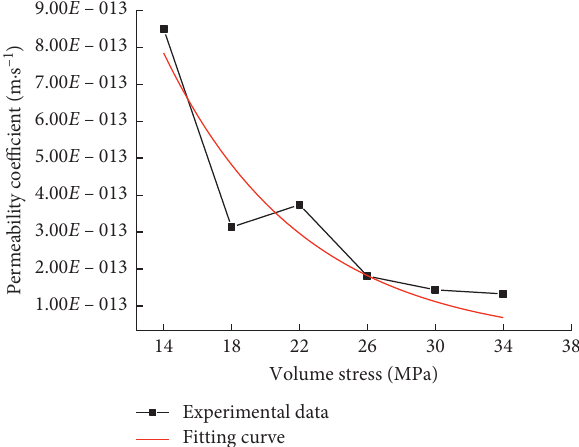
Figure 10: The curve of permeability coefficient versus volume